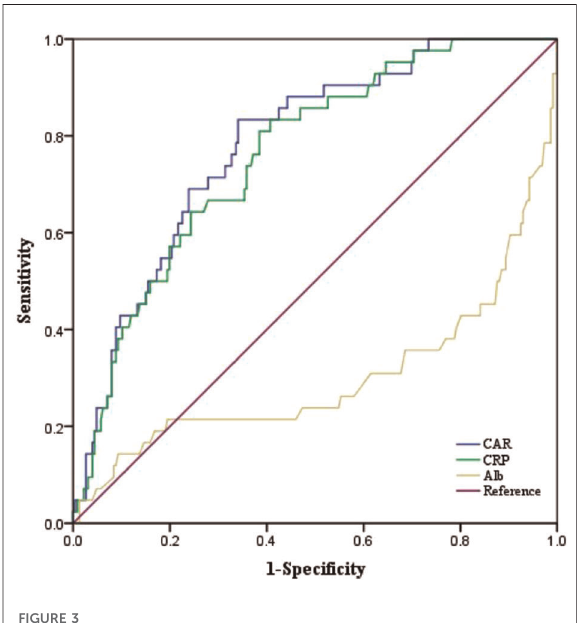
FIGURE 3 The ROC curves of CAR, CRP and Alb. Aberrative: ROC, receiver operating characteristic; CRP, C-reactive protein; Alb, albumin; CAR, C-reactive protein to albumin Ratio.